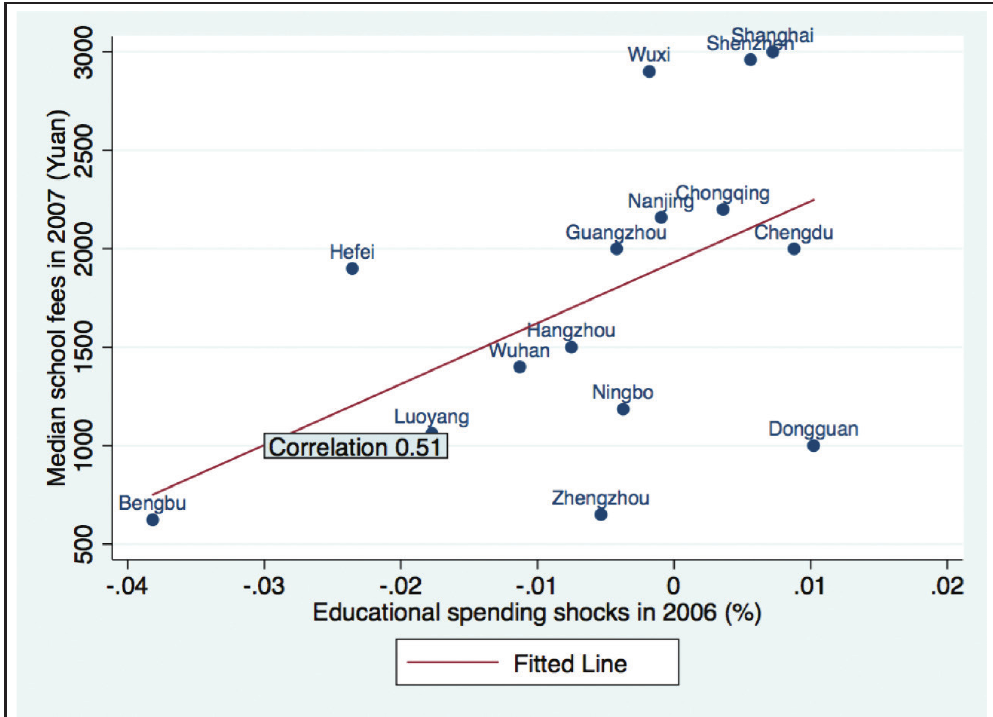
School fees and lagged education spending